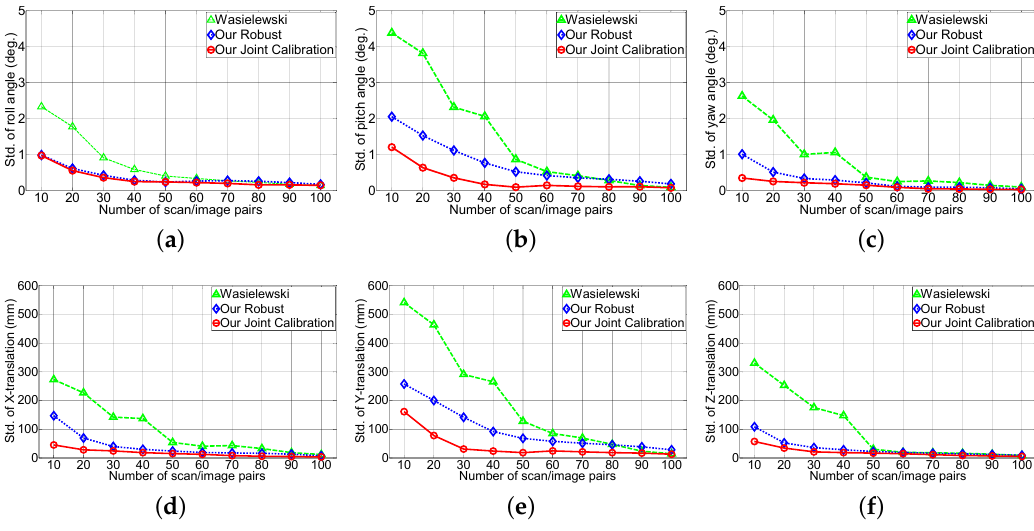
Figure 14. Effect of the rotation and translation accuracy w.r.t the number of scan/image pairs: ( a – c ) the standard deviation of the roll, pitch and yaw; and ( d – f ) the standard deviation of the translation on the X , Y and Z